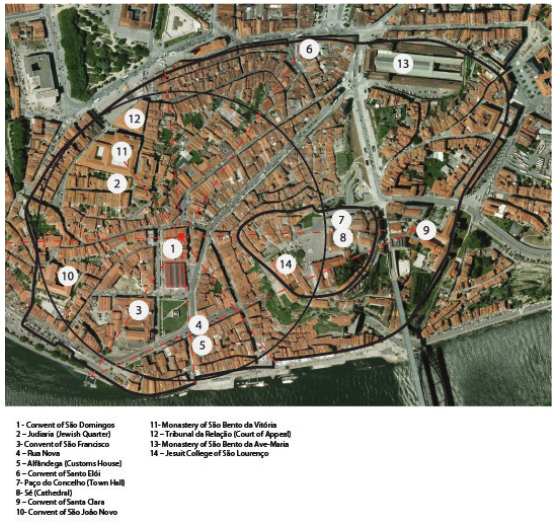
Figure 9: The city plan in the 16th